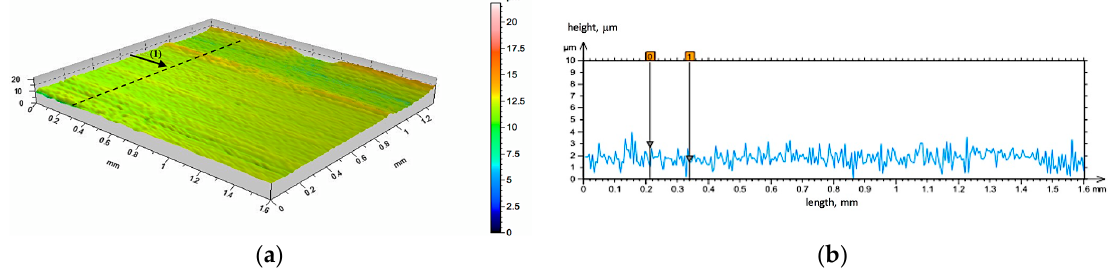
Figure 8. Initial state of the surface geometry of the unreinforced area: ( a ) 3D view; ( b ) height difference on line (1).